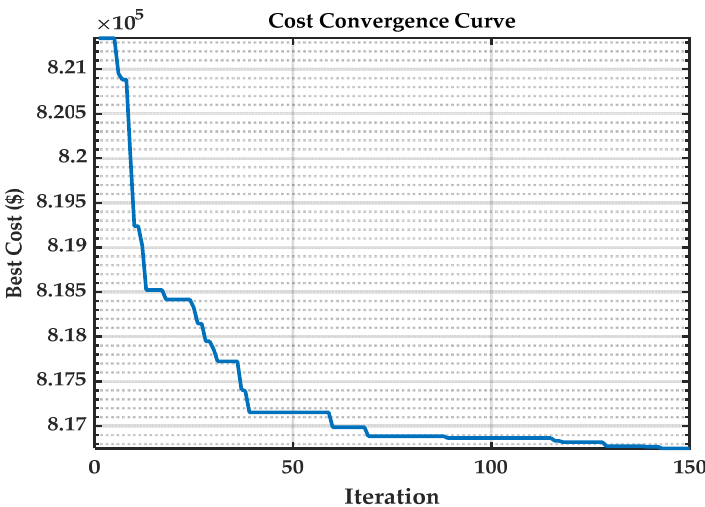
Figure 8. Cost convergence graph.